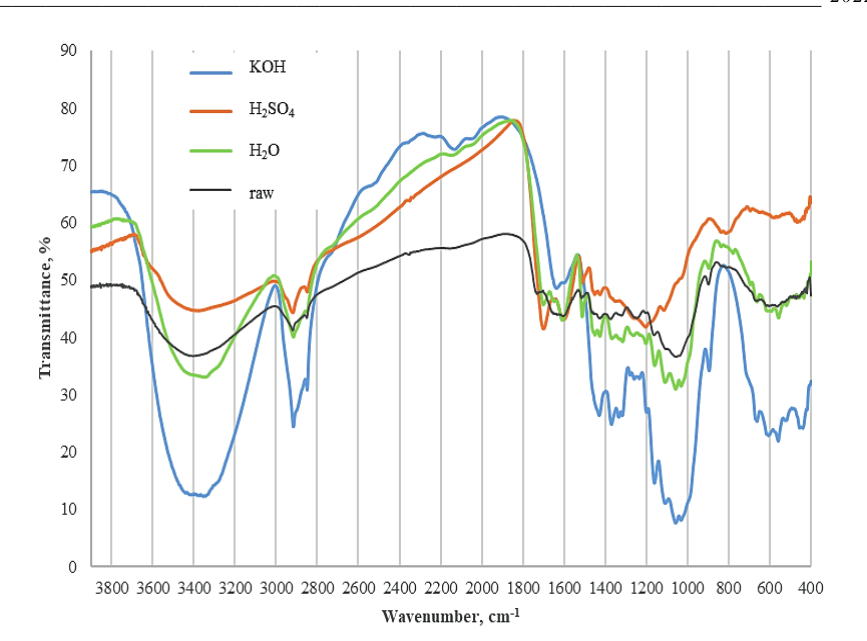
Fig. 7. FTIR spectra of hydrochar (HC) obtained using different catalysts (KOH, H 2 O or H 2 SO 4 ) of the HTC (WS biomass, 24 h, 200 °C). Thermogravimetric analysis of hydrochars obtained from different biomass types on example of hydrochar produced in alkaline environment reflect the differences in the composition of precursor biomass and its transformation process during carbonisation (Fig. 8). The first thermal degradation step determines the amount of water moisture (physically adsorbed water molecules) and gas particles that detach around 100 °C. For most hydrochars TGA analysis shows major weight loss at 320–400 °C that could be attributed to the removal of majority of functional groups as well as condensation This mechanism is common for lignocellulosic feedstock biomass (straw, cranberry press residues, leaves, potato peels) reactions resulting in the development of highly condensed aromatic structures composing char. Significantly different is the thermal transformation process of HC obtained from algae and coffee grounds, as in the first case, during biomass waste development a part of water soluble substances are removed, but in case of algae significant differences of the biomass composition exist. Fig. 9 shows the TGA differences for wheat straw HC obtained from neutral or acid HTC,